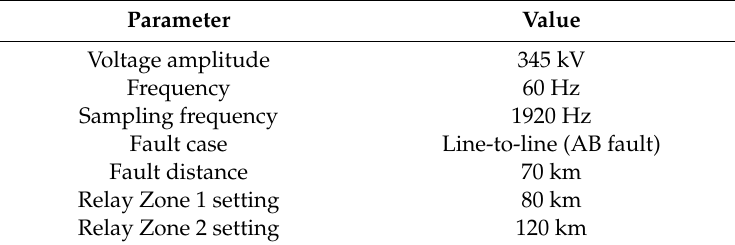
Figure 5. Two sources-based power system for simulations of the effect of time synchronization on distance protection algorithm. Table 5. Parameters used in computer